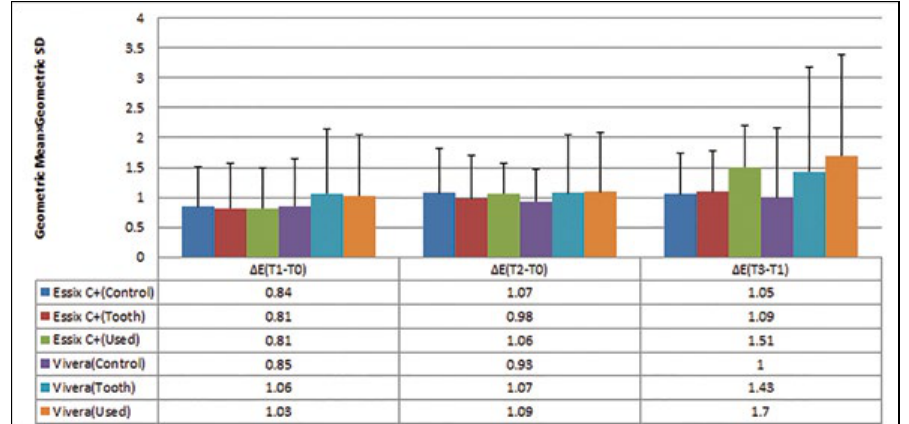
Figure 2. Geometric Mean × Geometric SD of the parameter ΔE for tooth 11.